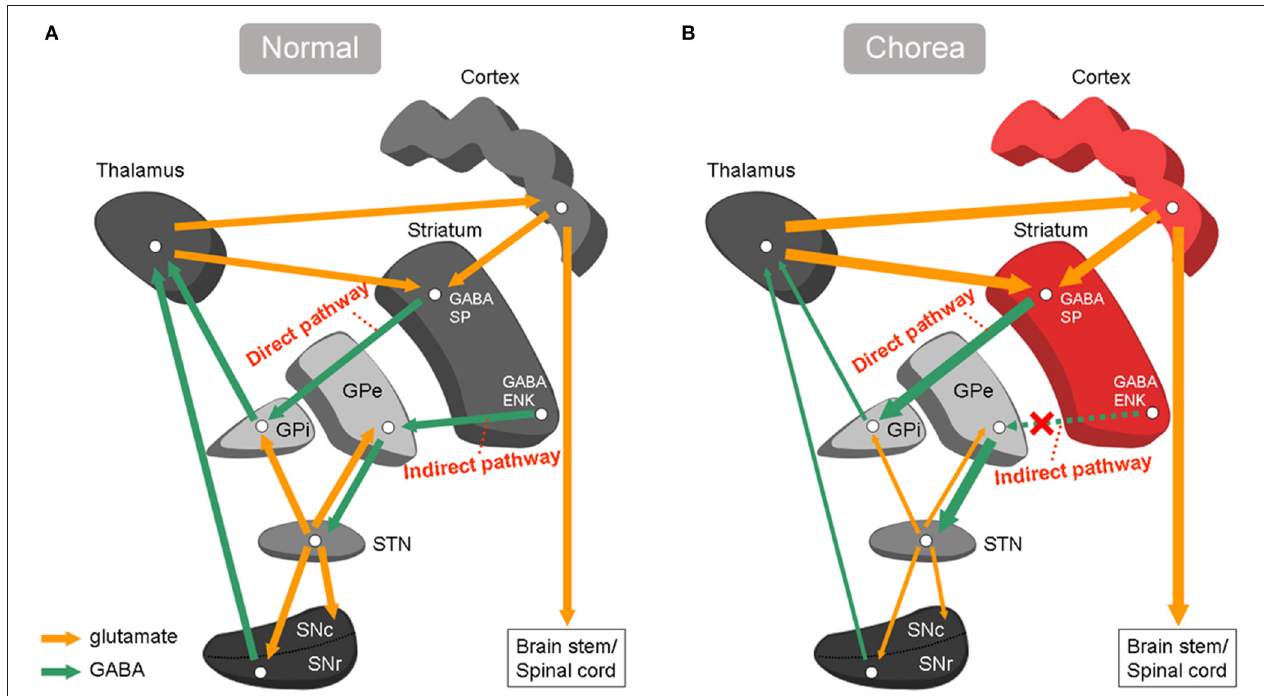
FIGURE 4 | Basal ganglia circuitry under normal conditions and chorea. (A) Normal conditions: the striatum projects to output neurons in Gpi through a direct pathway, and by a indirect pathway via GPe and STN. (B) Chorea: under-activity in indirect pathway cause increased activity of excitatory glutamatergic thalamostriatal and thalamocortical projection neurons. SP, substance P; ENK, enkephalin; Gpi, globus pallidus internus; Gpe, globus pallidus external; STN, subthalamic nucleus; GABA, γ -aminobutyric